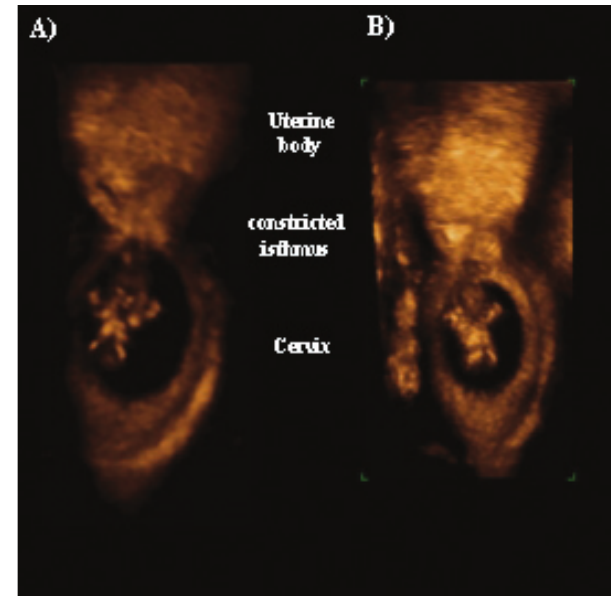
Figure 3 . Three-dimensional sonogram (rendered images) showing the precise location of the pregnancy inside the cervix, with the constricted isthmus being the upper limit of the cervical